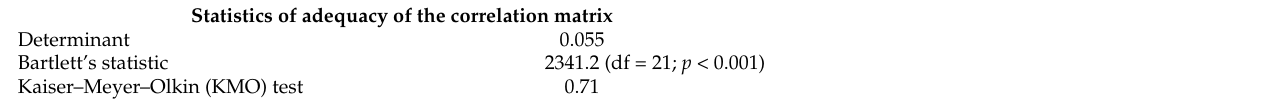
Item Correlation